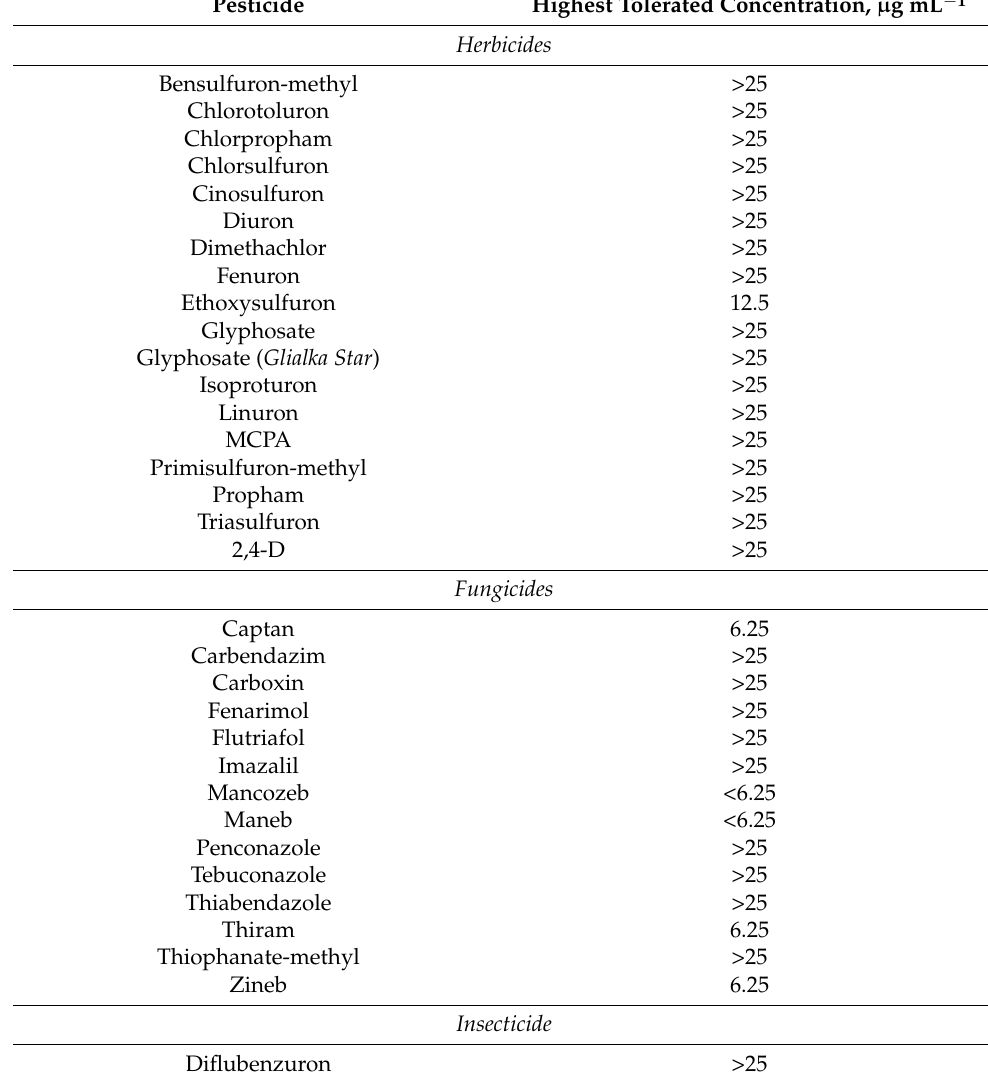
Table 4. The highest concentration of pesticides tolerated by Pseudomonas resinovorans SZMC